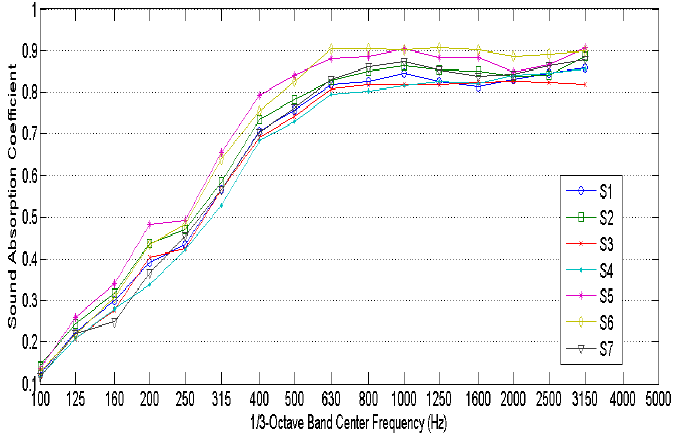
Figure 5. Measured diffuse field sound absorption coefficients.